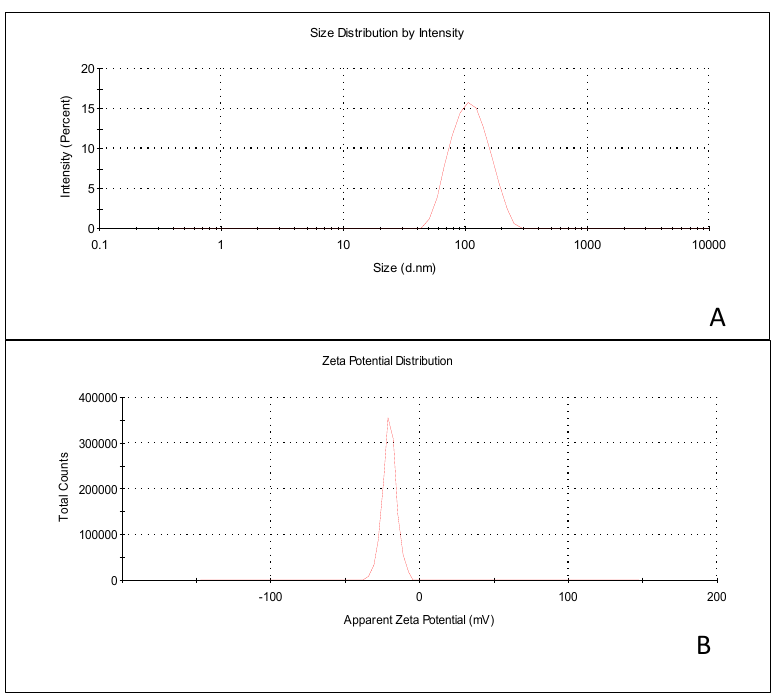
Figure 4. ( A ) Particle size distribution and ( B ) zeta Potential of AZA-LIPO formulation.